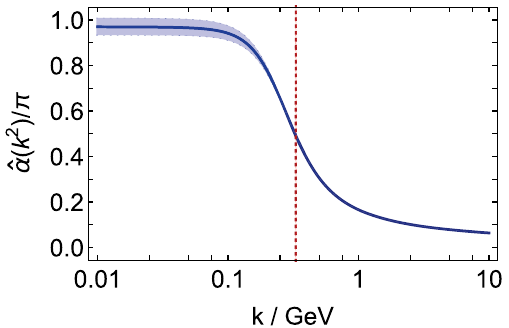
Fig. 1 Process-independenteffectivecharge, ˆ α( k 2 )/π ,computedelse- where [38] and interpolated using Eqs.(13), (14). (The band bracket- ing the solid blue curve expresses the uncertainty in ˆ α( k 2 = 0 )/π = 0 . 97 ( 4 ) . Details are provided in Ref. [38].) The vertical dashed red line marks the screening mass k = m G = 0 . 331 ( 2 )